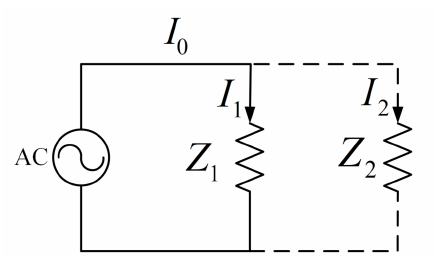
Figure 3. The principle of current differential